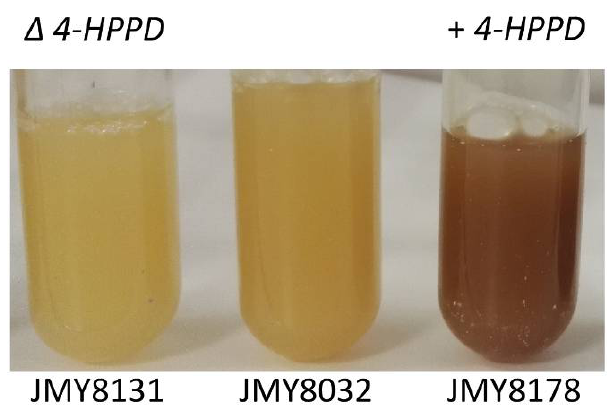
Figure 4. Effect of 4HPPD disruption and overexpression on brown pigment production in the strain JMY8032 in YPD medium after 4 days of culture.